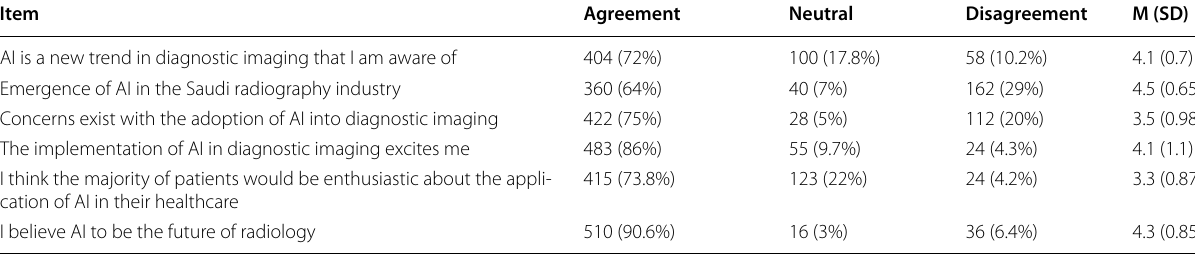
Table 2 General thoughts and views of respondents toward clinical use of AI in diagnostic